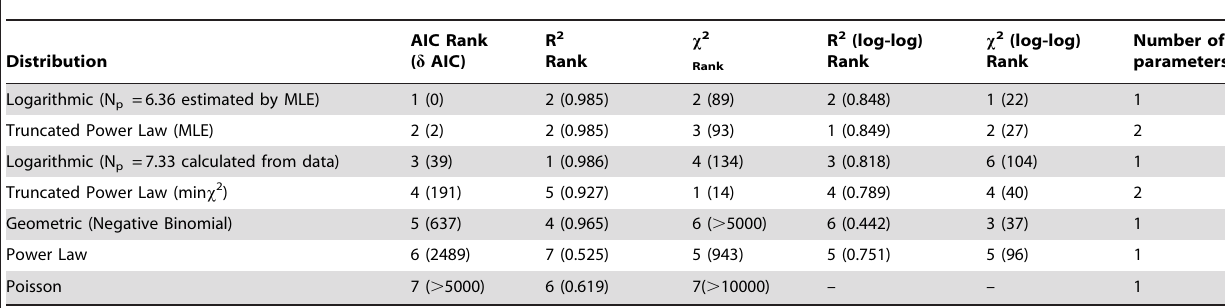
Table 1. Comparison of five statistics for proposed